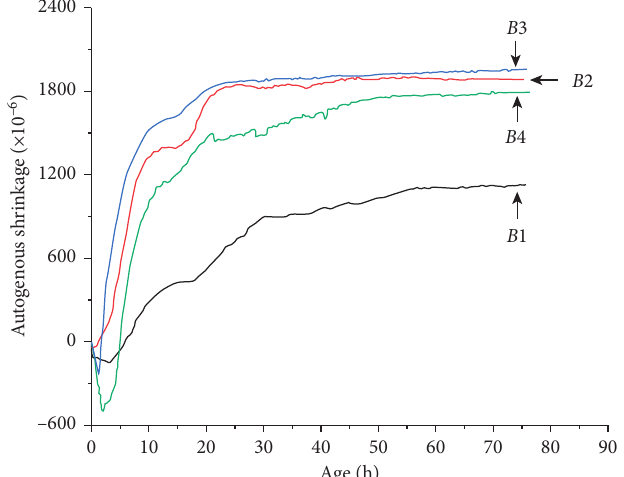
Figure 6: Effects of NC on the autogenous shrinkage of UHPC ( B 1 � 0% NC; B 2 � 2% NC; B 3 � 3% NC; B 4 � 4% NC; h �